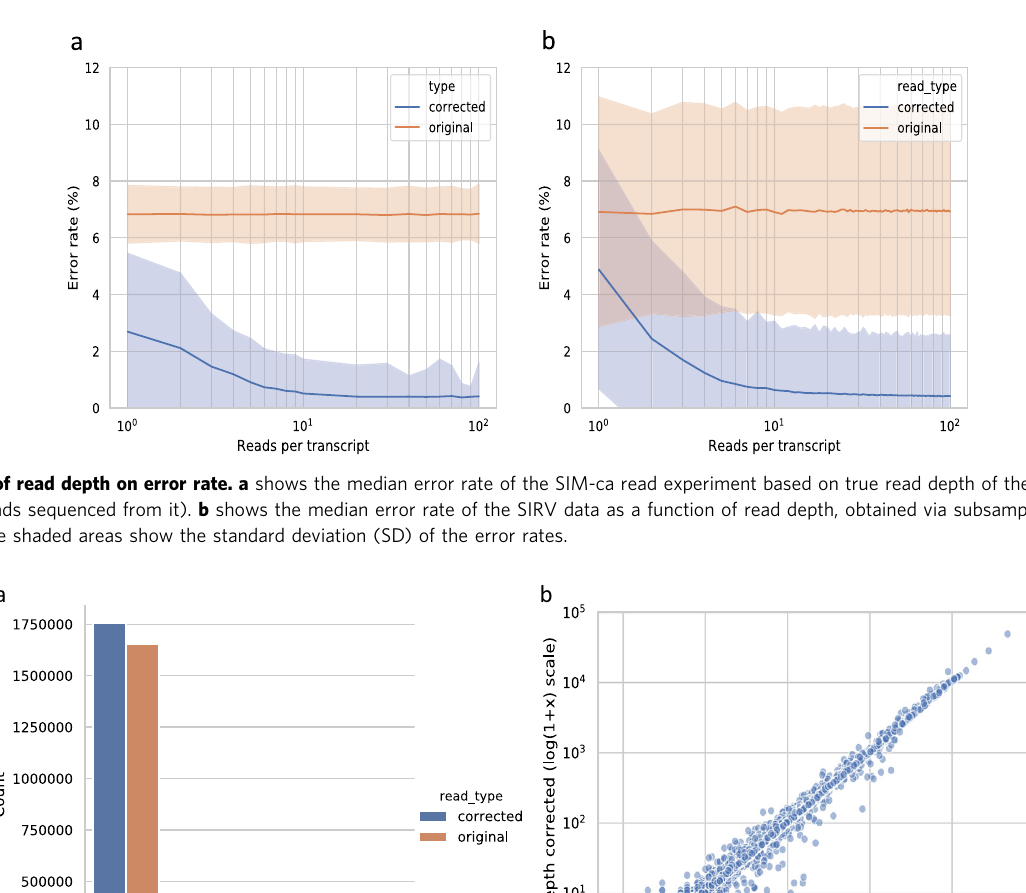
(Fig. 3b). Out of the 178 transcripts that were not captured by an FSM read after correction, 107 and 37 of them had only one and two FSM original reads, respectively, and all but 4 of them occurred in less than 10 original reads. Therefore, a consequence of our correction algorithm is that the lowest abundant transcripts may be miscorrected. However, we also observed 99 transcripts had no FSM support before correction but did after error correction. As the error correction is reference agnostic, this is likely due to reads from annotated transcripts that were misaligned around splice sites prior to correction, and highlights the bene fi t of reference-free error correction.